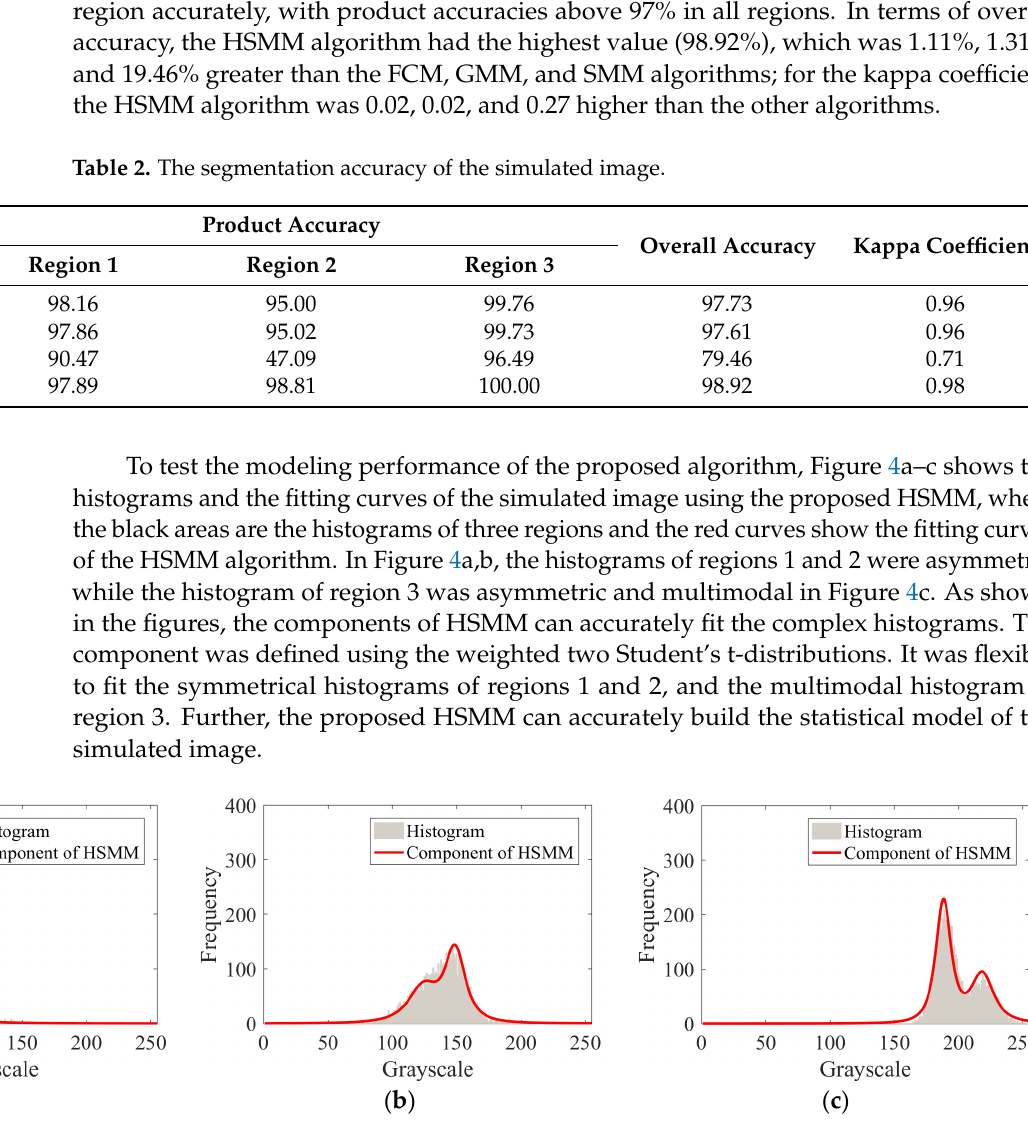
Figure 4. The fitting results of the histogram of the simulated image. ( a – c ) regions 1–3.